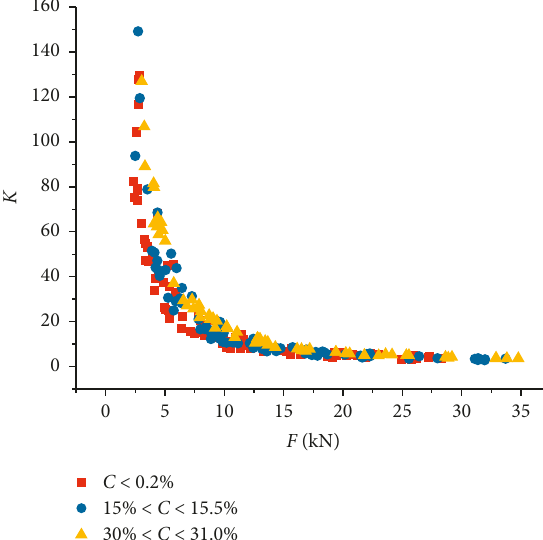
Figure 11: Layer of Pareto-optimal solutions for